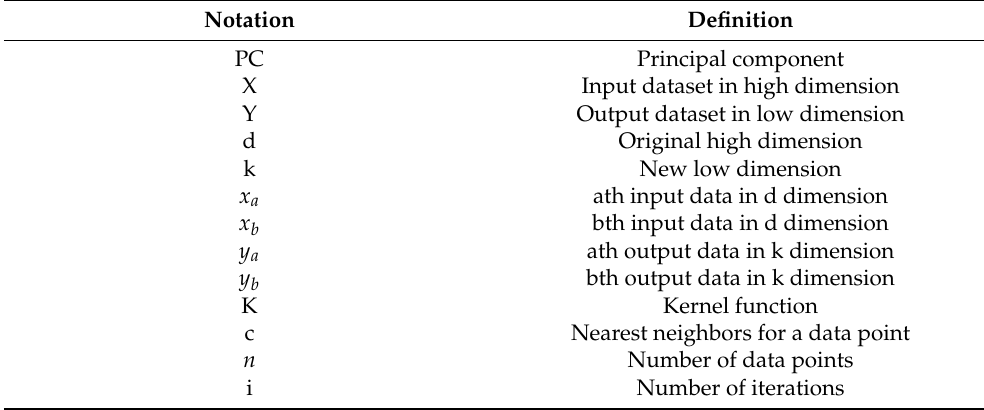
Table 4. Notation adopted in the description of the following data reduction methods